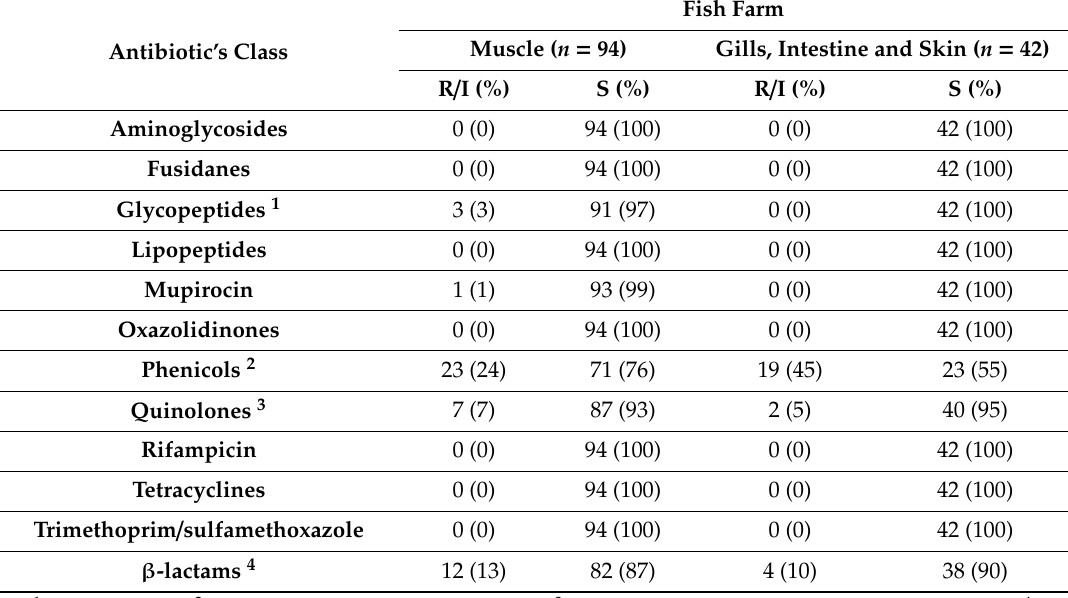
Table 6. Antibiotic susceptibility testing results of the 136 strains found in this study (these results do not include known intrinsic non-susceptibilities).